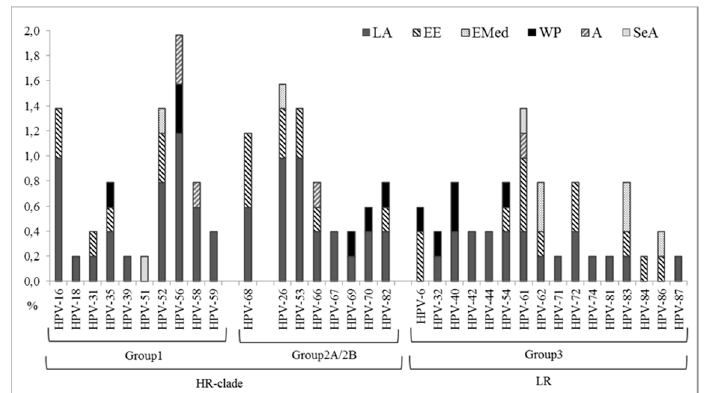
Figure 1. Distribution of HPV types among women ( n = 508, excluding 29 women with untyped